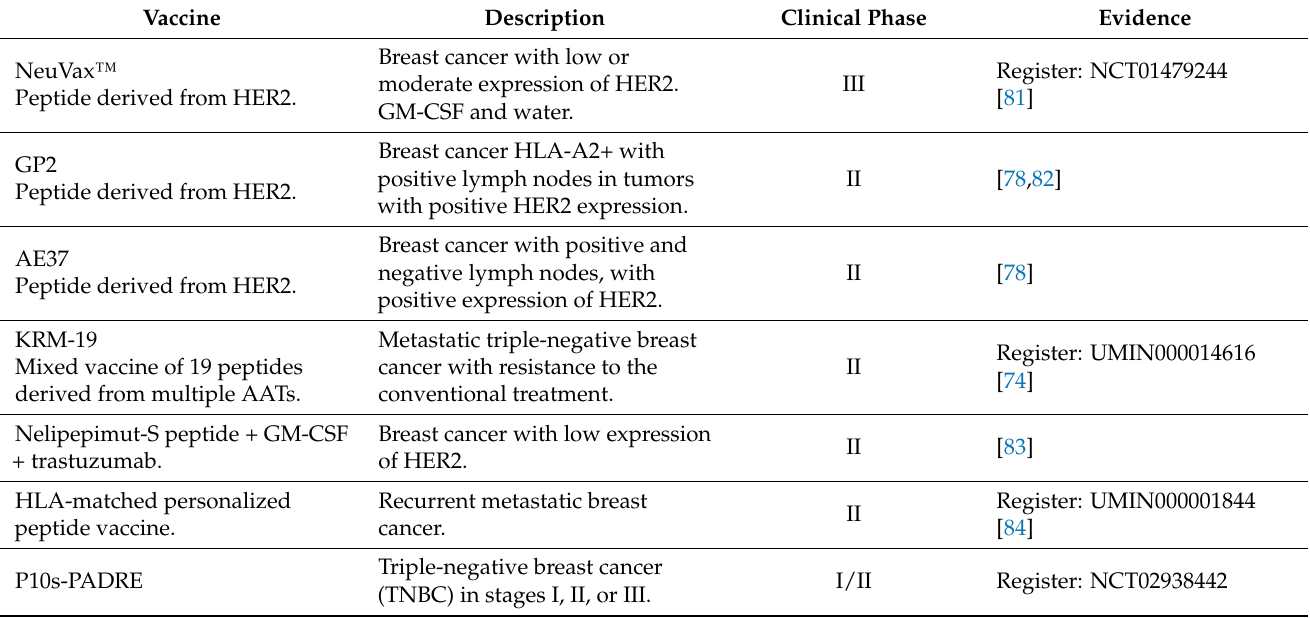
Table 1. Peptide-based vaccines derived from TAA against breast